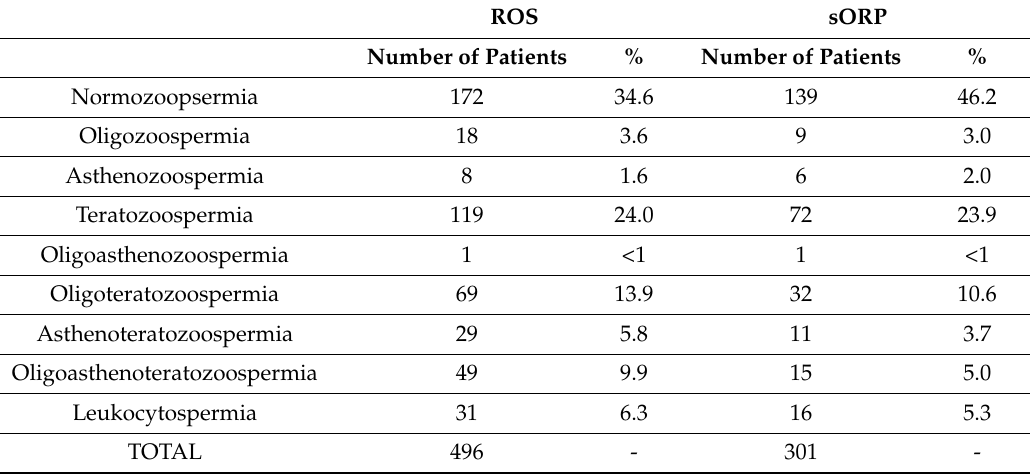
Table 1. Distribution of semen samples classified according to WHO (2010) criteria in the patient study